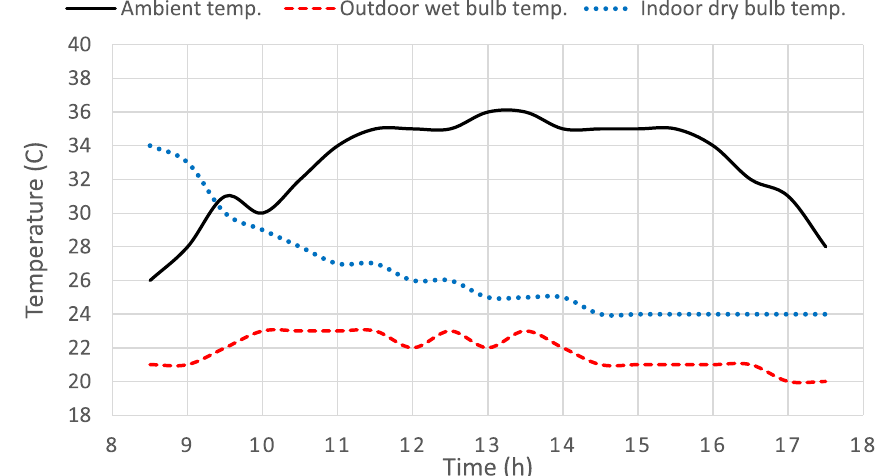
Fig. 6 Variation of temperatures with time for day 1